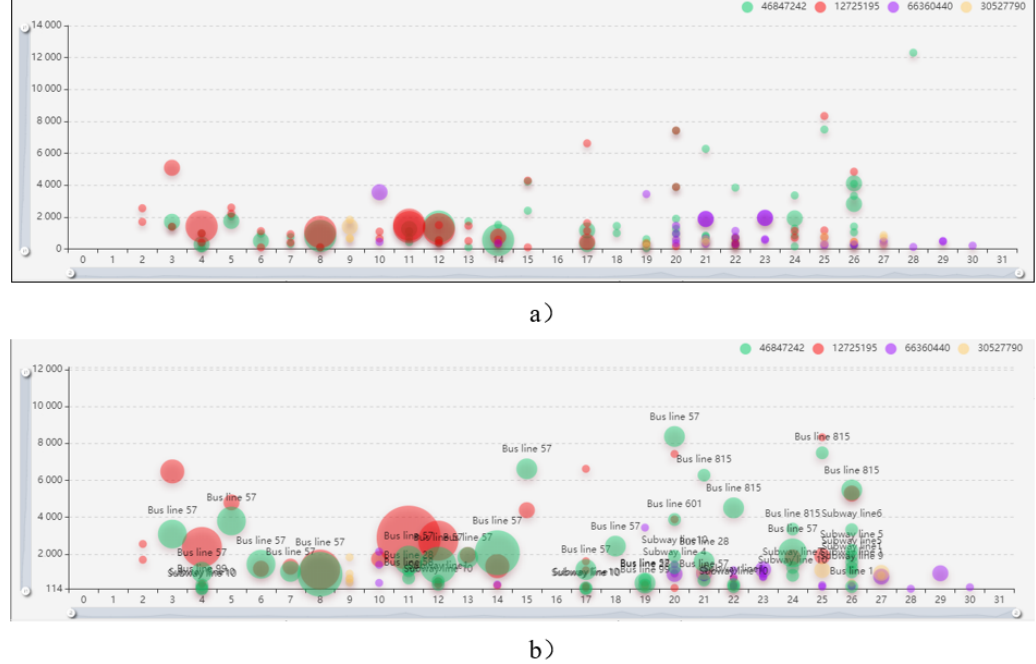
Figure 9. Bubble view of the passenger travel ( a ) Overview of the bubble view, ( b ) Display the information of the vehicle represented by the